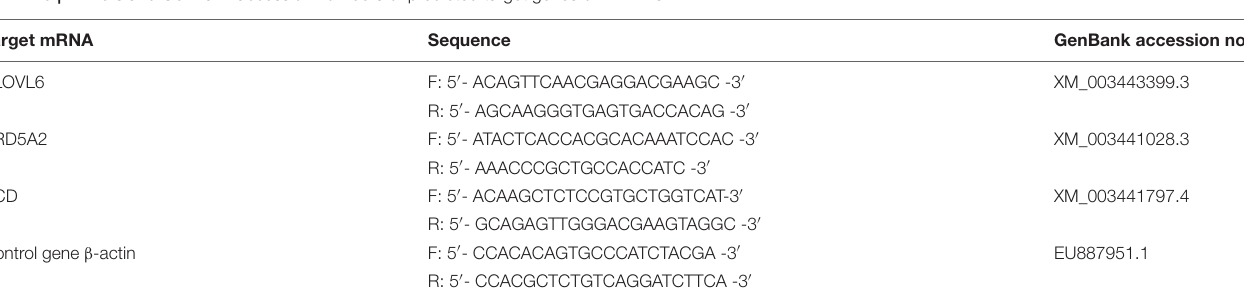
TABLE 3 | Primers and GenBank accession numbers of predicted target genes of